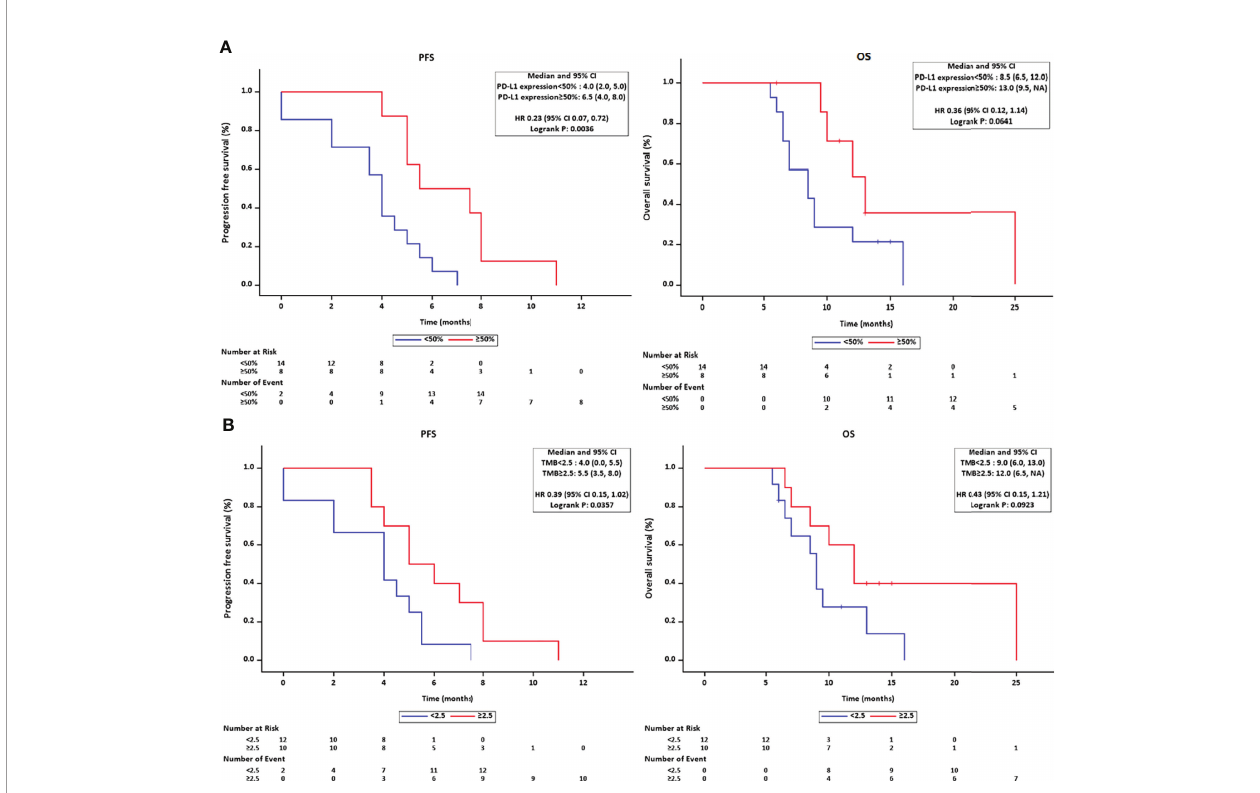
FIGURE 6 | (A) The Kaplan – Meier method estimated the survival length in PD-L1-positive/-negative subgroups and found a marginal superiority for RFS in the PD- L1 positive group. (B) A signi fi cant longer PFS was observed in the higher TMB